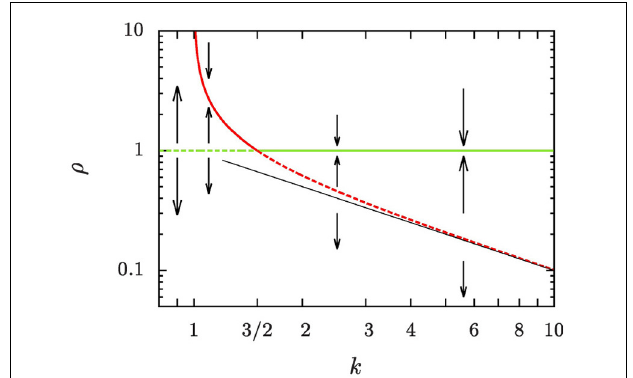
FIGURE 1 | Phase portrait of the evolution of the reduced aggregate radius ρ = R / (cid:2) R (cid:3) . Dashed lines denote unstable fixed points, and solid lines stable ones. The green lines denotes a fixed point at ρ = 1, and the red lines the position of another fixed point, ρ + , defined in Equation (16b). A thin straight black line has been added to show that ρ + rapidly approaches k − 1 for k (cid:2)